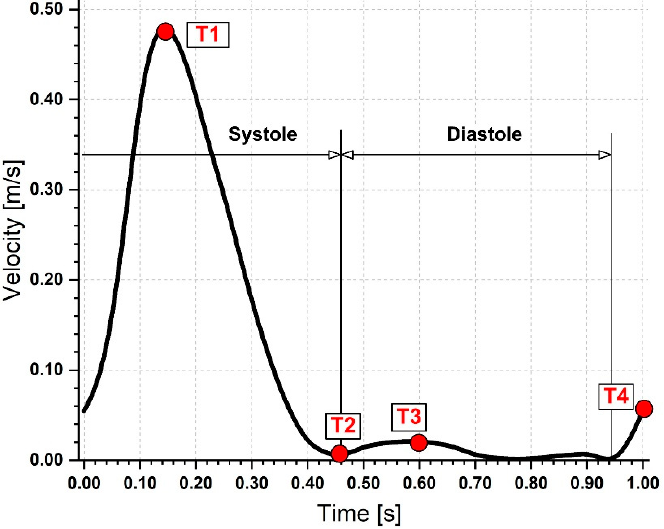
Figure 7. Physiologically realistic velocity waveform used in the numerical simulation. Time steps used for hemodynamic parameters investigation.